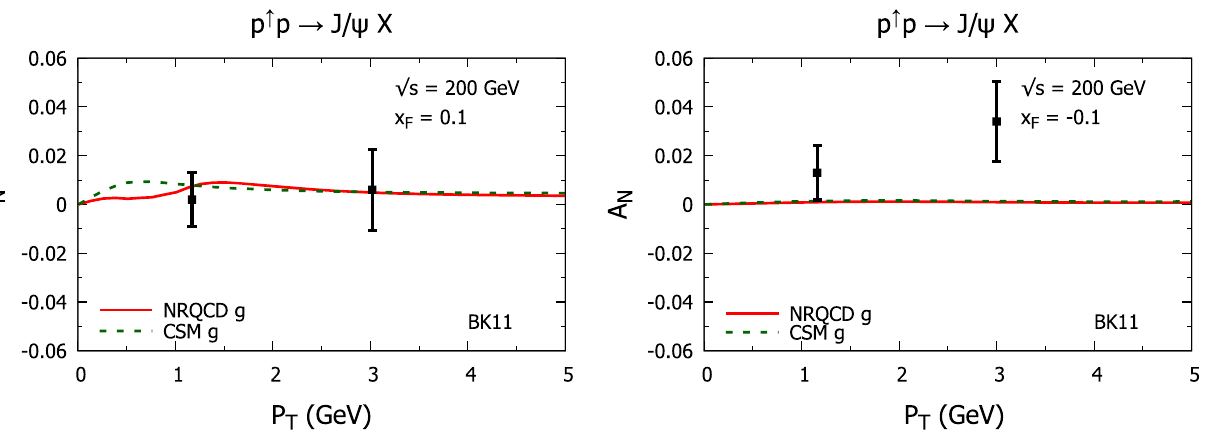
approach (red solid line), adopting the BK11 set, compared against PHENIX data [8]. The curves are calculated adopting the parameters in